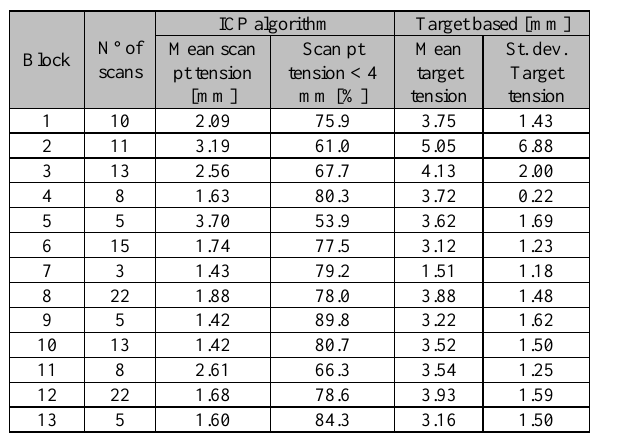
Table 9. Accuracy results of the LiDAR registration procedures (tension = re-projection discrepancies)